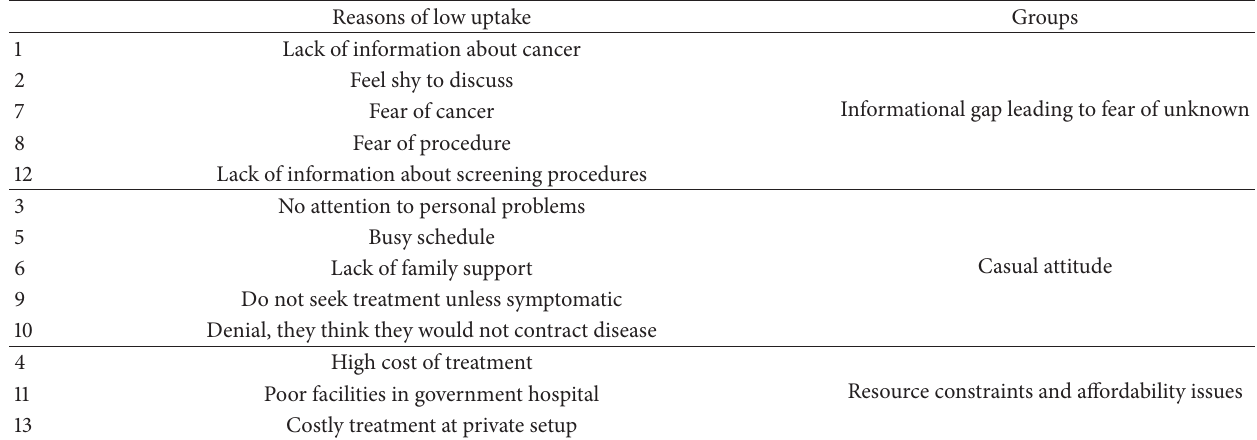
Table 7: Clustering of perceived reasons for low uptake of cervical cancer screening.